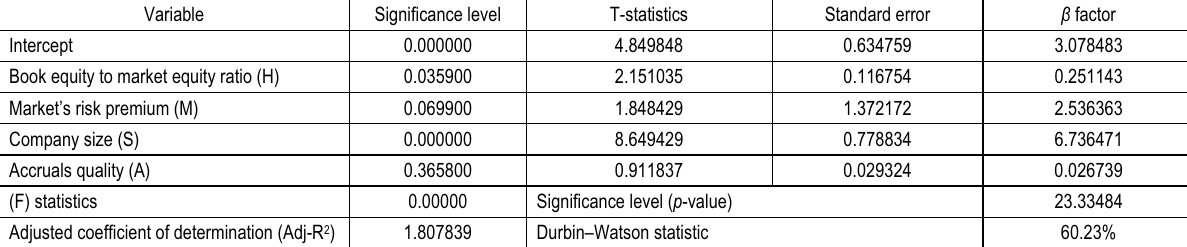
Table 7. Relationship between investments anomaly and stock’s risk